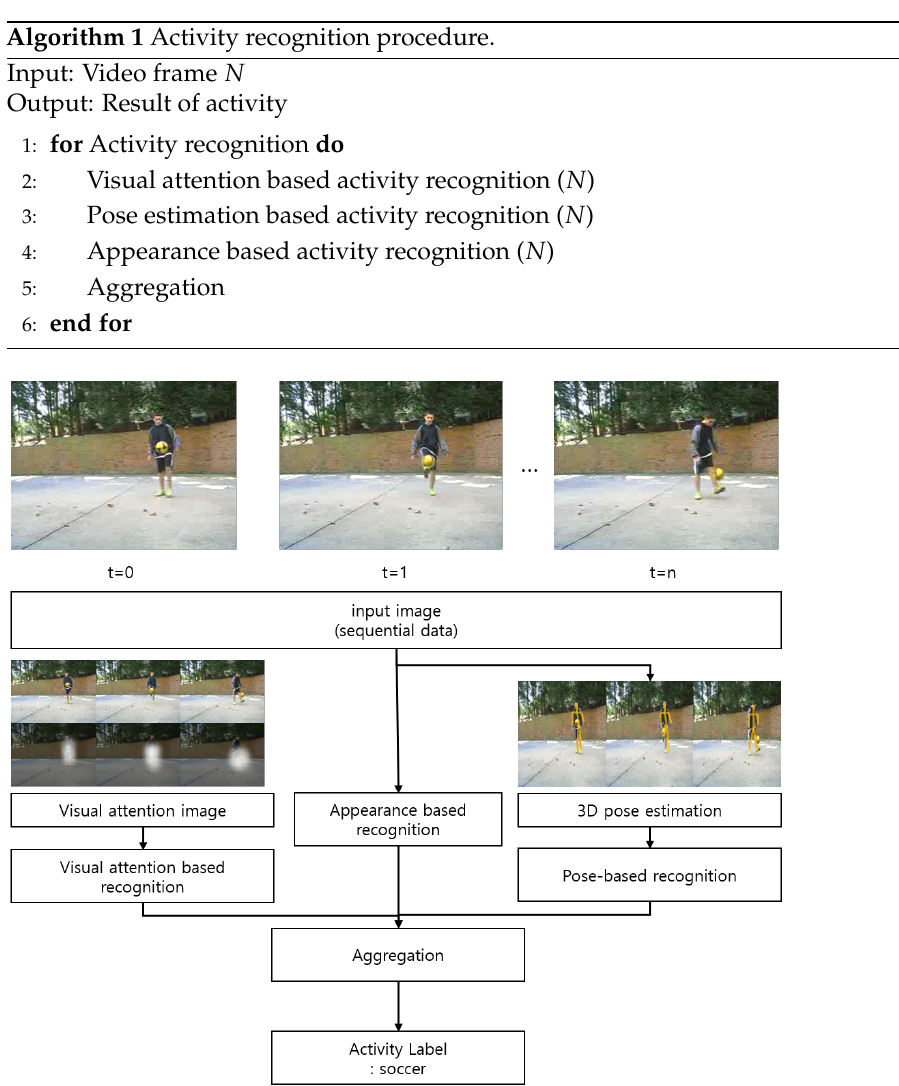
Figure 2. Overall structure of the proposed algorithm. Our method provides 2D/3D pose estimation from video frames. Pose, visual and appearance are used to predict activities in a unified